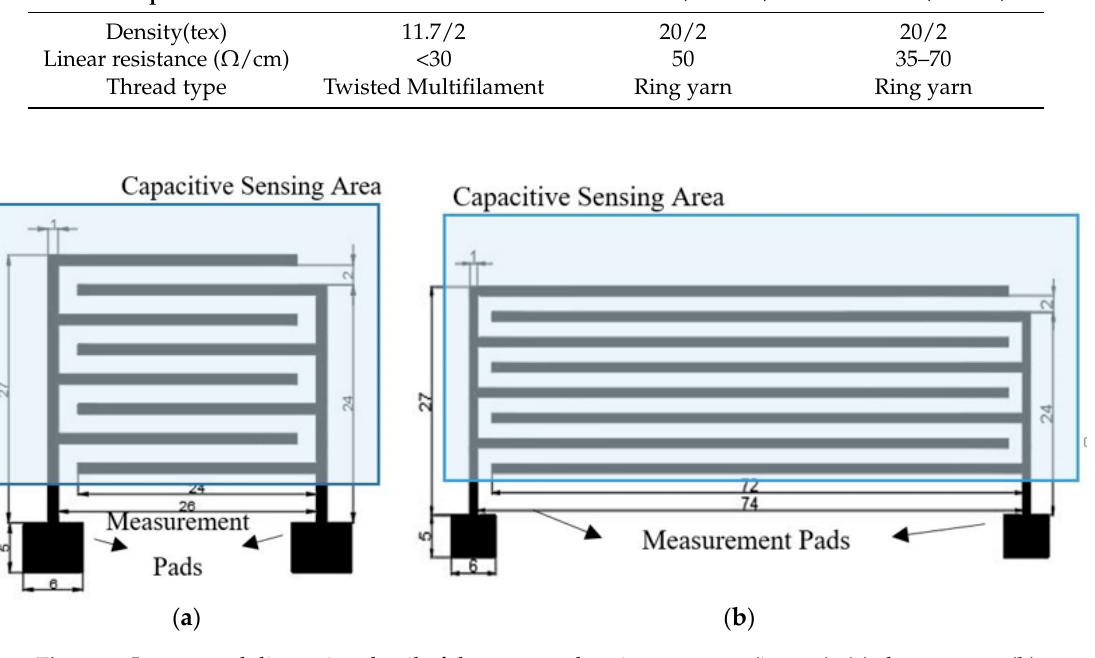
Figure 1. Layout and dimension detail of the proposed moisture sensor (in mm): ( a ) short sensor; ( b ) long sensor. The bottom squares correspond to the characterization pads.